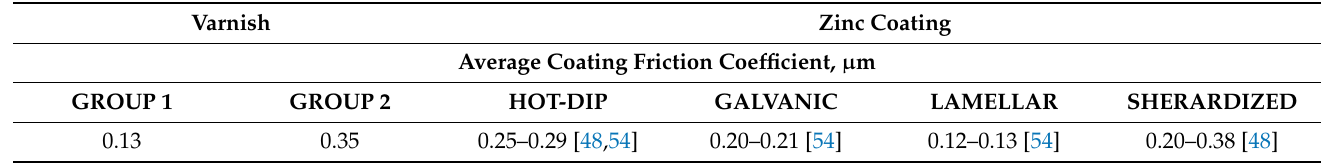
Figure 8. The macrostructure of the analyzed coatings after friction tests: ( a ) Group 1, ( b ) Group 2.